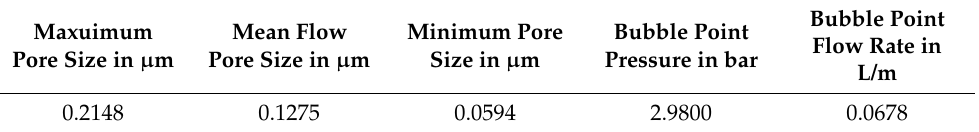
Table 1. Pore size characteristics for ceramic membranes.